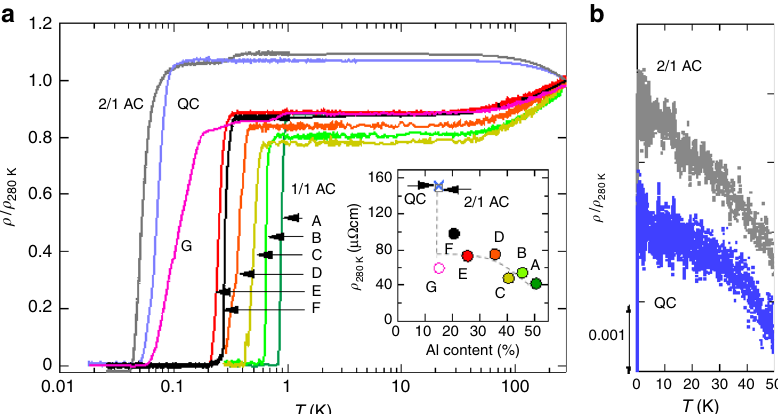
denotes the resistivity at T = 280 K. The samples plotted Fig. 4 Electrical resistivity. a Temperature dependence of normalized electrical resistivity. ρ 280 K are the as-cast 1/1AC_A, E, F, G samples, the annealed 1/1AC_B, C, D samples, the 2/1AC sample, and the QC sample. The 1/1AC_G is a mother ingot of the QC. Inset: Electrical resistivity at T ¼ 280 K as a function of Al content. The broken line is a guide to the eyes: note that the resistivity of the QC and the 2/1AC is larger than that of the 1/1AC samples. b Temperature dependence of normalized resistivity of the QC and the 2/1AC in an expanded scale below 50 K. The data are shifted vertically for clarity. Note that they show the negative temperature coef fi cient of resistivity